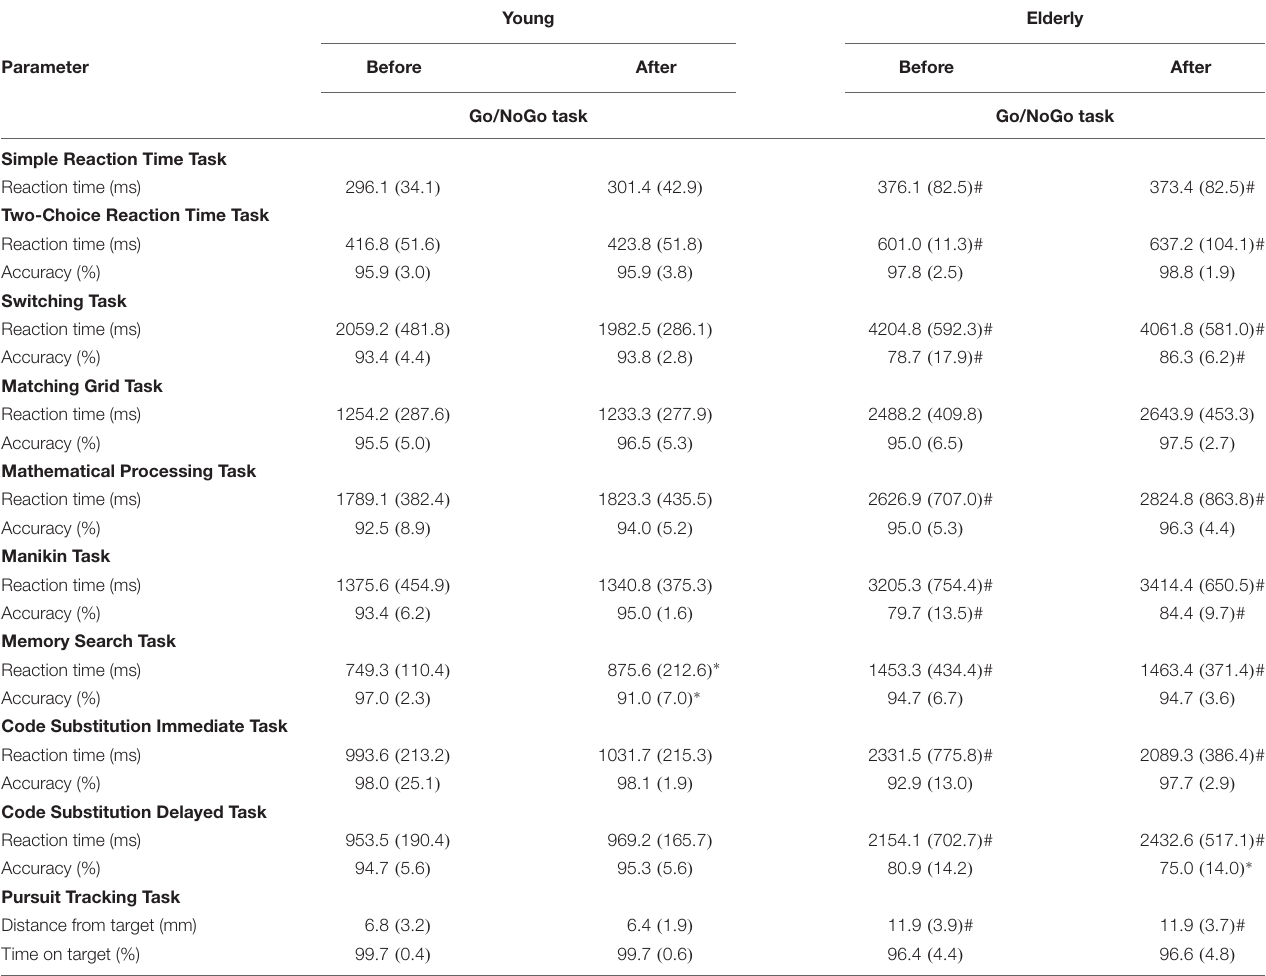
TABLE 2 | Cognitive performance before and after a 2 h “Go/NoGo” task. Young